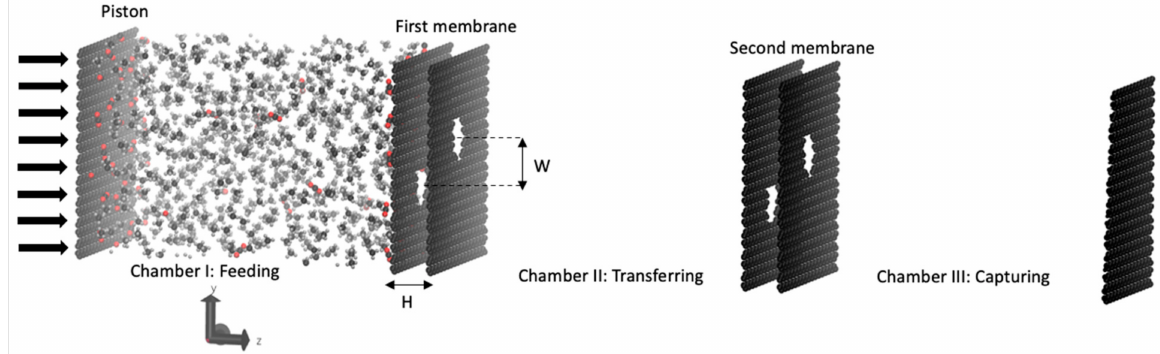
Figure 1. Initial configuration of the two-stage bilayer NPG membrane for CH 4 /CO 2 separation. Initially, a binary mixture of 20% CO 2 and 80% CH 4 with 27 CO 2 molecules and 297 CH 4 molecules was loaded into the left chamber, while both chambers on the right side were vacuum for all simulations. Inside the feeding chamber, the molecules of each